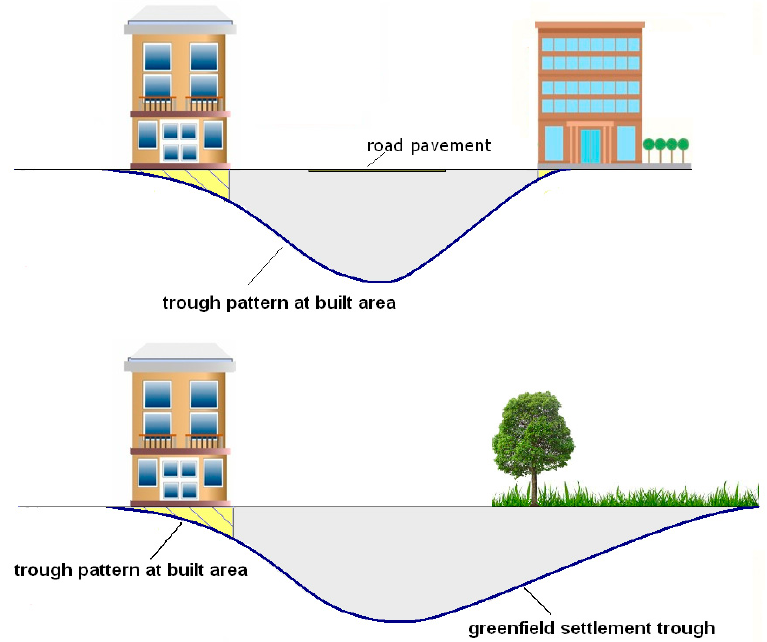
Figure 5. Geodetic observations of ground loss and tilting (benchmarks on building and on ground) indicate symmetric subsidence troughs if buildings exist at both sides of the tunnel ( top ), but asymmetric if buildings are on one side and a greenfield on the other ( bottom ).